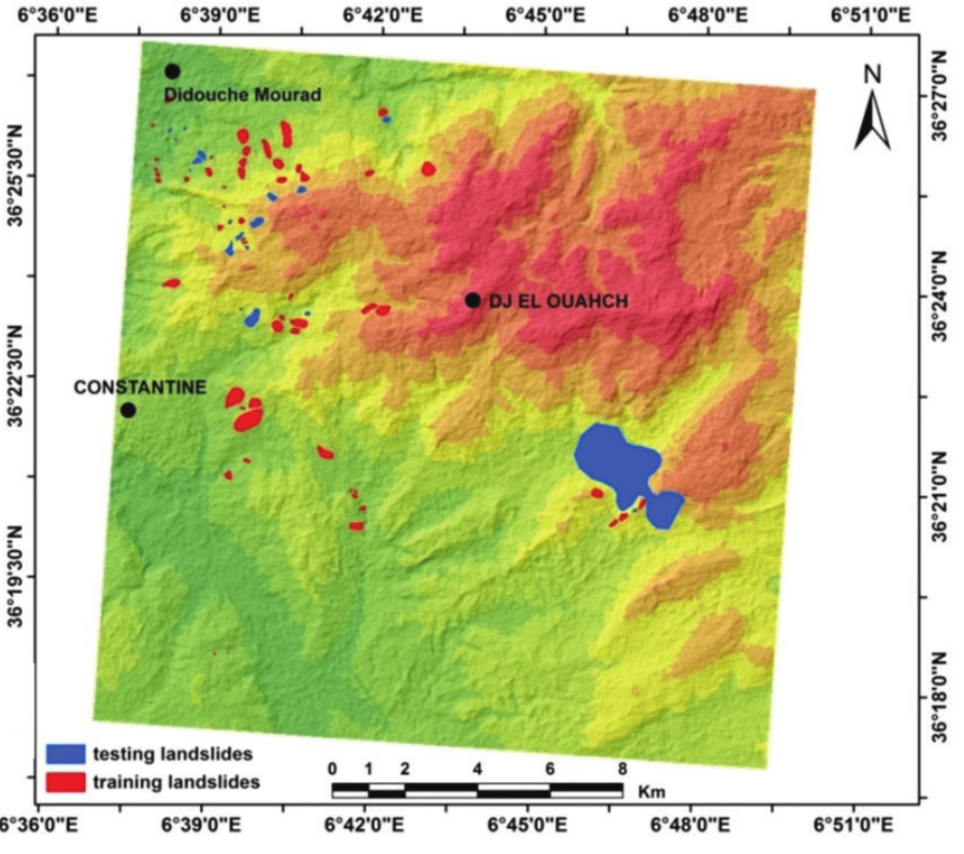
Figure 3: Landslide inventory map of the study